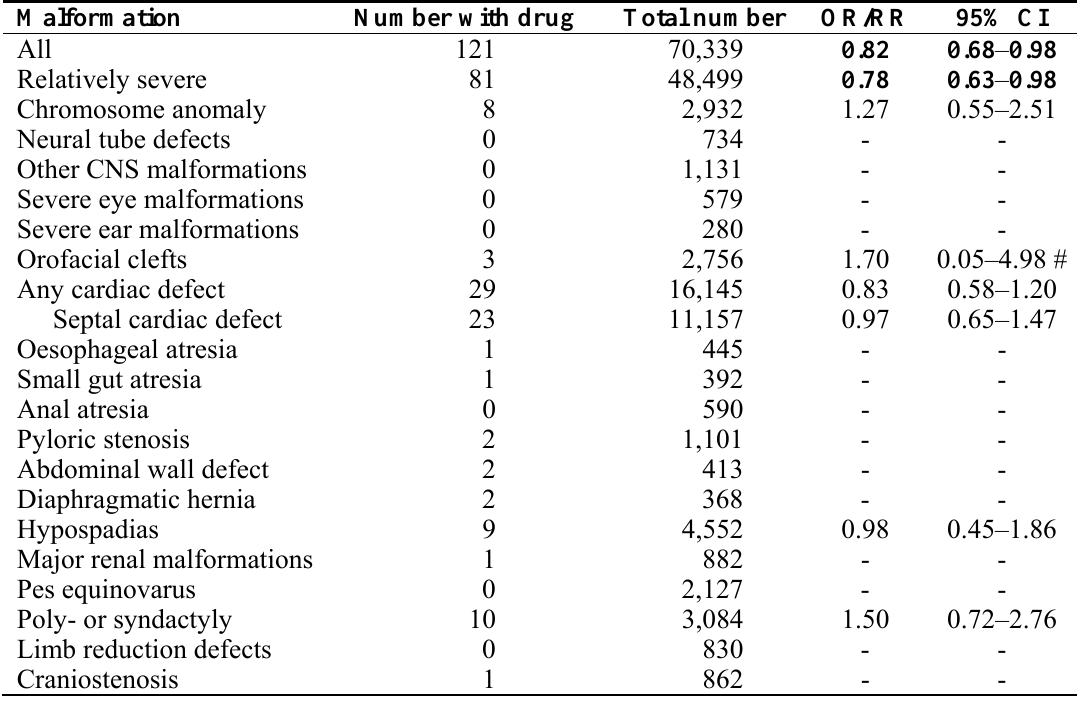
Table 21. Congenital malformations observed after maternal use of dixyrazine or prochlorperazine. Bold text marks statistical significance.